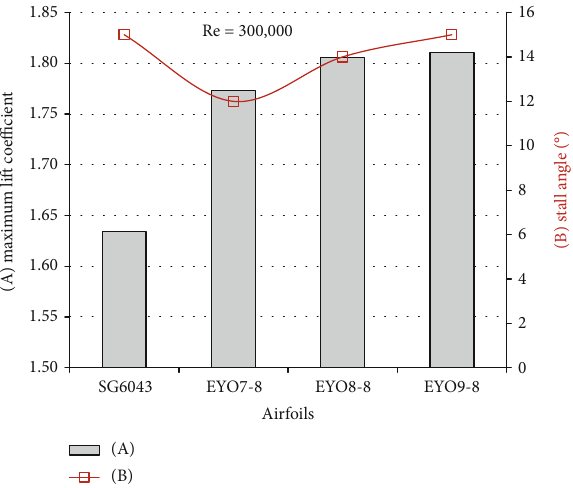
Figure 6: L / D performances of SG6043 and EYO-Series airfoils at Re = 300,000 .